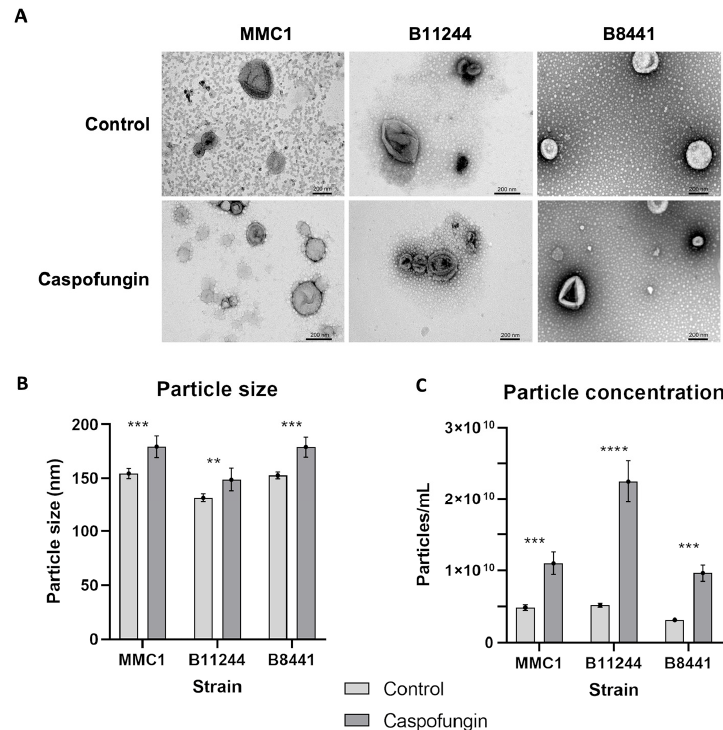
Figure 1. Characterization of Candida auris extracellular vesicles (EVs). ( A ) Transmission electron microscopy images of EVs derived from MMC1, B11244 and B8441 strains under control conditions and caspofungin treatment. bar = 200 nm. ( B ) Particle size distribution bar chart for MMC1, B11244 and B8441 EVs from control (light grey) and caspofungin treatment (dark grey). The average EV size ( y -axis) is indicated in nm. The x -axis indicates the strains studied, where *** p < 0.005 and ** p < 0.05, by individual t-tests followed by Bonferroni’s multicomparisons test for three independent experiments. ( C ) A particle concentration bar chart related to EVs concentration calculated the three strains from control and caspofungin treatment; the y -axis indicates the particles concentration, *** p < 0.001 and **** p < 0.0001, by one-way Anova followed by Bonferroni’s multicomparisons test for three independent experiments. The EV size is indicated in nm. 3.2. Caspofungin Treatment Led to Alteration in the EV RNA Content Caspofungin treatment resulted in a change in the composition of RNA in EVs. Dis- tinct classes of RNA molecules were identified as full-length mRNAs and most of the RNAs identified are ncRNAs smaller than 200 nucleotides that included anti-sense RNAs, tRNAs, other ncRNAs and rRNA, as described in other fungi species [34]. In order to identify full-length mRNAs, we filtered transcripts with a 5× of minimum reads coverage (Figure 2A). In total, 87 transcripts were identified as common to all the strains, 59 were detected in at least two strains, 37 were abundant in the B8441 strain, 25 mRNAs were found in the B11244 and one was found in the MMC1 strain (Figure 2B and Tables S1–S5). For the common transcripts, cell wall, nucleosome core, and ribosome, the enriched terms, and the identification of ribosomal proteins, is similar to what was ob- served for the transcriptome when whole yeast cells were treated with caspofungin [20] (Figure 2C). For the transcripts common to at least two strains, we observed translation related transcripts, heat shock and chaperones (Table 1). For the specific transcripts for the B8441 strain, the enriched terms were posttranslational modification, protein turnover,